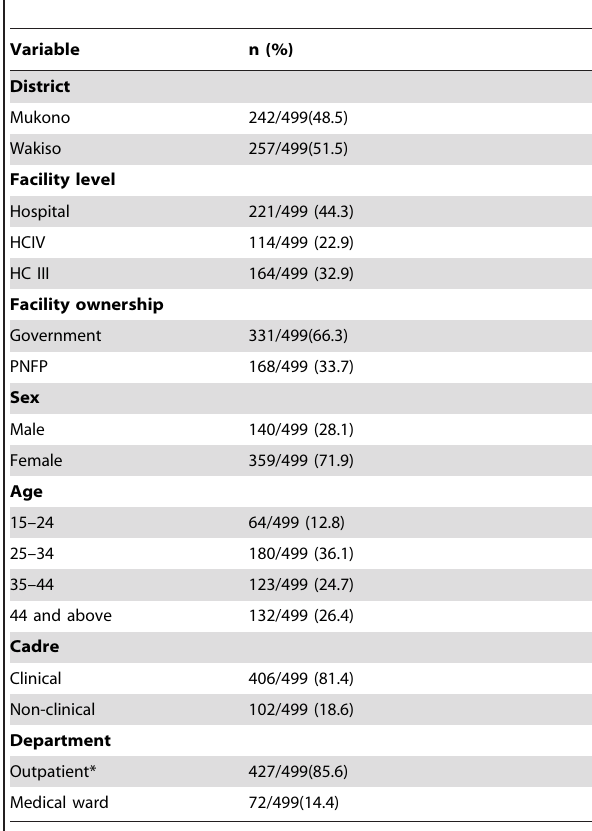
Table 1. Socio-demographic characteristics of health care workers from Mukono and Wakiso districts in